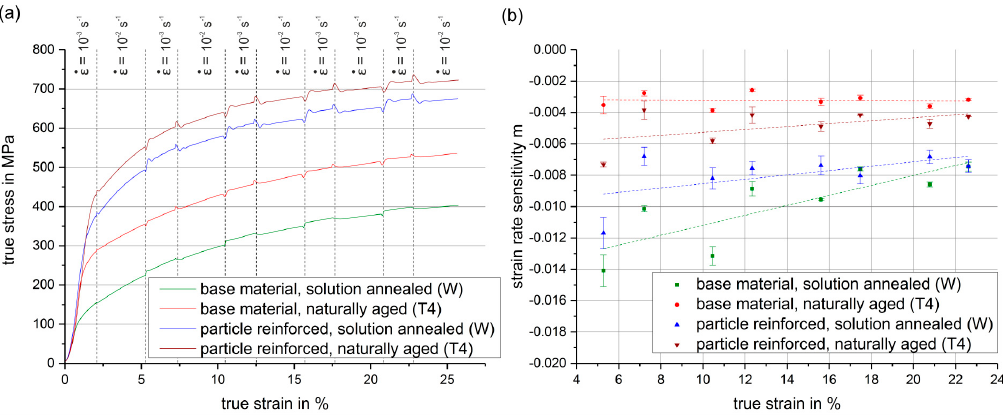
Figure 5. Compression tests with alternating strain rates between 10 − 3 s − 1 and 10 − 2 s − 1 . ( a ) True stress-true strain curves of jump tests for both materials in solution annealed (W) and naturally aged condition (T4). ( b ) Strain rate sensitivity m versus true strain calculated from the true stress-true strain curves in a).